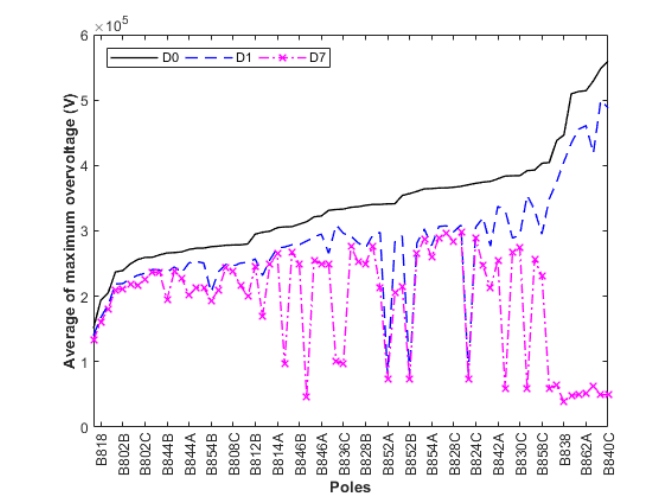
Figure 21. Average values of maximum overvoltages for Case 2: without lightning arresters (D0); lightning arresters installed at the transformer’s pole only (D1); and installed at the six critical poles plus the transformer’s pole